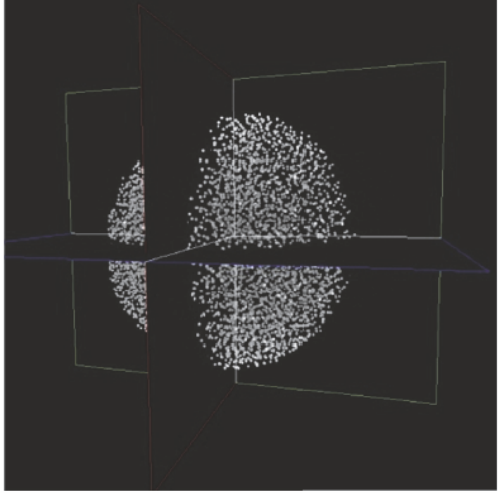
Figure 2: 3D volume rendering of TRISO particles in a spherical fuel